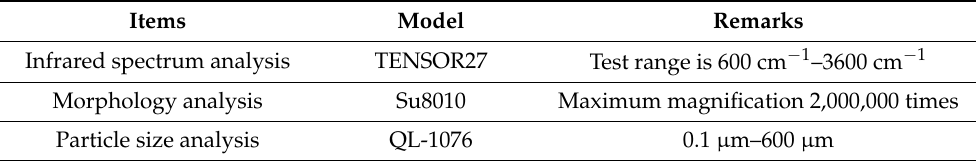
Table 4. Characterization items of dielectric microcapsules.